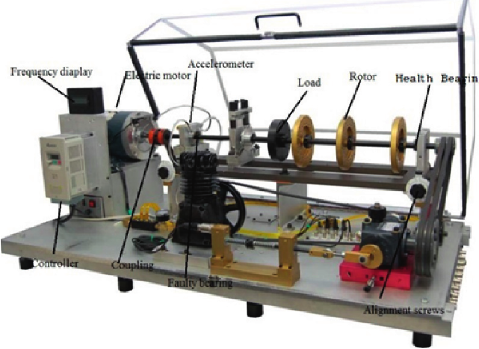
Figure 17: Machine fault simulator. Table 2: Specific parameters of bearing ER-16K.